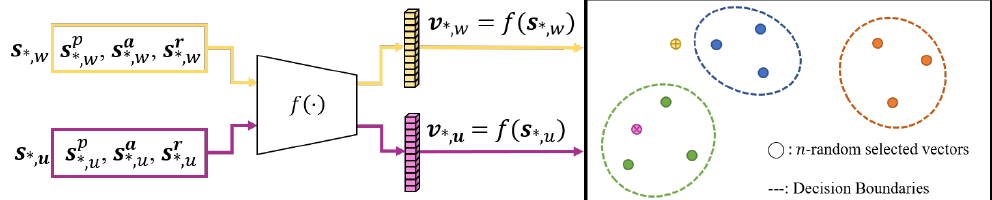
Figure 4. Illustration of gait recognition using the trained model. In the example, unit step s ∗ , u is recognized as that of the “green” subject, whereas unit step s ∗ , w is not